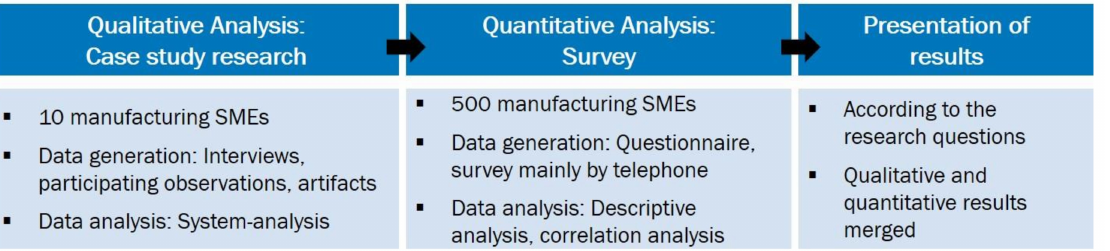
Figure 2. Research